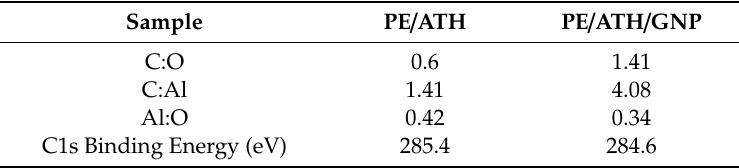
Table 3. XPS data of char residue of PE / ATH and PE / ATH / GNP after Cone